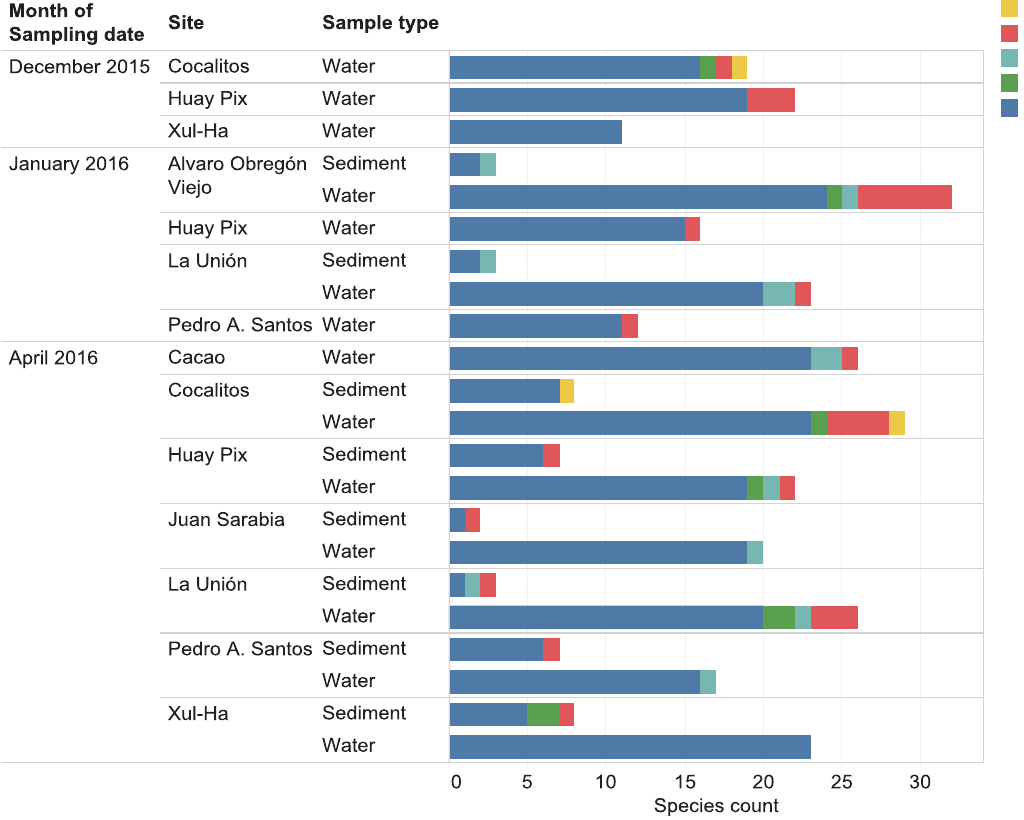
Fig 4. Number of vertebrate species recovered in eDNA from each sampling event at each collection site.